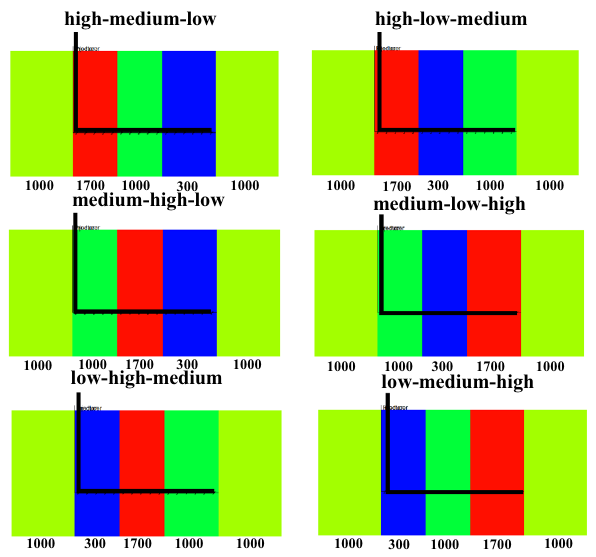
Fig. 3 The detailed permeability distribution pattern along the hori- zontal wellbore